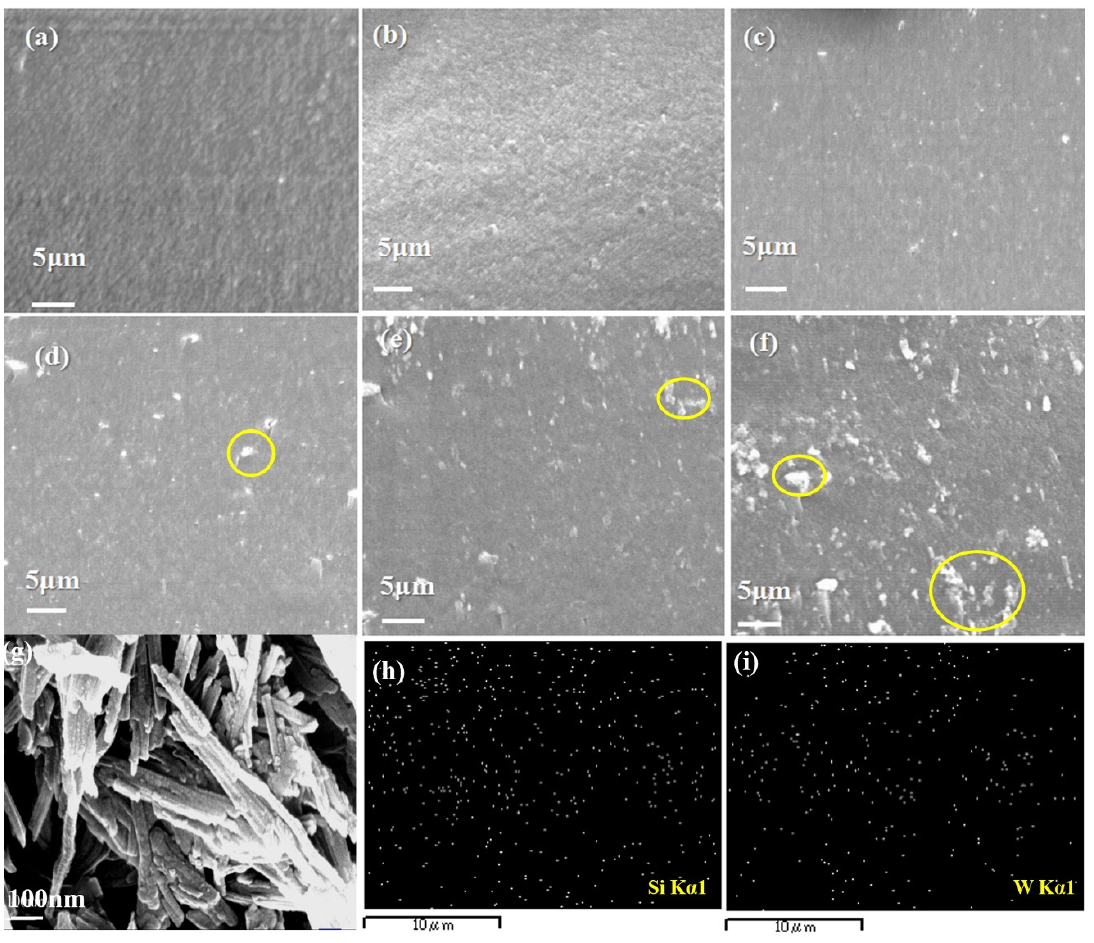
Figure 3. Cross-sectional SEM images of the membranes: ( a ) CS, ( b ) CS / WQAT-2, ( c ) CS / WQAT-4, Figure 3. Cross ‐ sectional SEM images of the membranes: ( a ) CS, ( b ) CS/WQAT ‐ 2, ( c ) CS/WQAT ‐ 4, ( d ) ( d ) CS / WQAT-8, ( e ) CS / WQAT-10, ( f ) CS / WQAT-15; ( g ) SEM image of WQAT; EDX mapping images of CS/WQAT ‐ 8, ( e ) CS/WQAT ‐ 10, ( f ) CS/WQAT ‐ 15; ( g ) SEM image of WQAT; EDX mapping images of Si ( h ) and W ( i ) distribution in the CS / WQAT-4 Si ( h ) and W ( i ) distribution in the CS/WQAT ‐ 4 membrane.